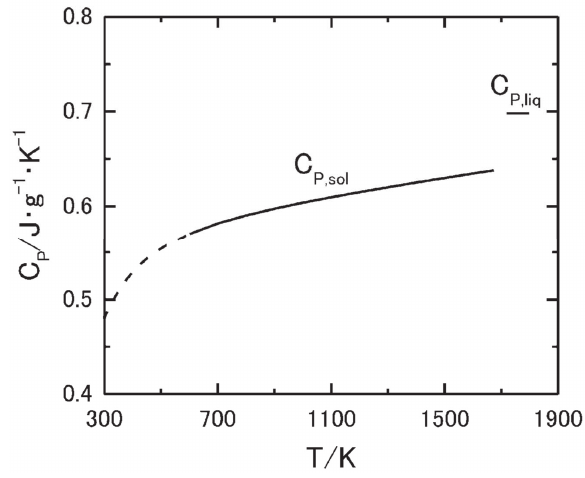
Figure 6. Heat capacity of SUS304 stainless